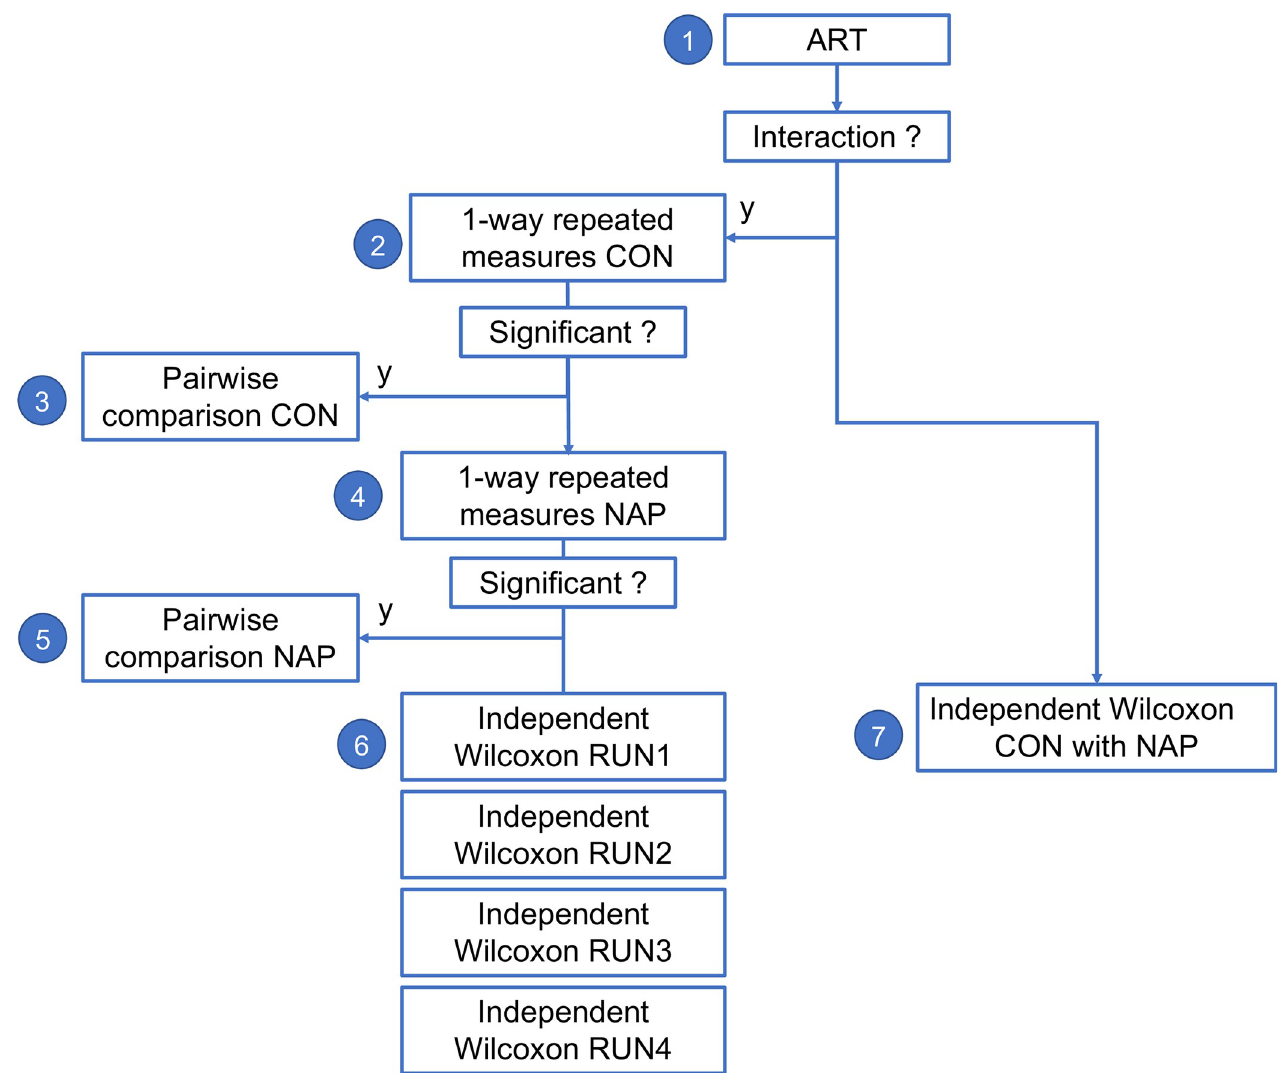
Fig 11. Statistical flowchart for non-parametric testing of differences between groups across runs. 1) 2x4 non-parametric ANOVA using Align rank transform (ART). 2) Friedmann repeated measures test. 3) Paired Wilcoxon test. 4) Friedmann repeated measures test. 5) Paired Wilcoxon test. 6) Independent Wilcoxon test for each run. 7) Independent Wilcoxon test across all